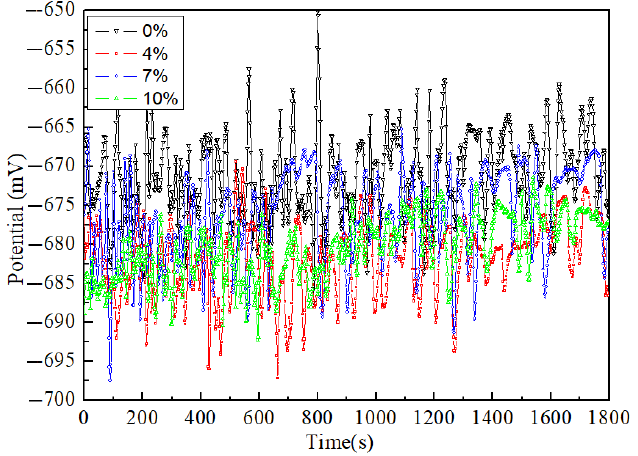
Figure 2. Open circuit potential of the 2024 FSWed joints with different deformations (0%, 4%, 7%, and 10%) in the 3.5% NaCl electrolyte.